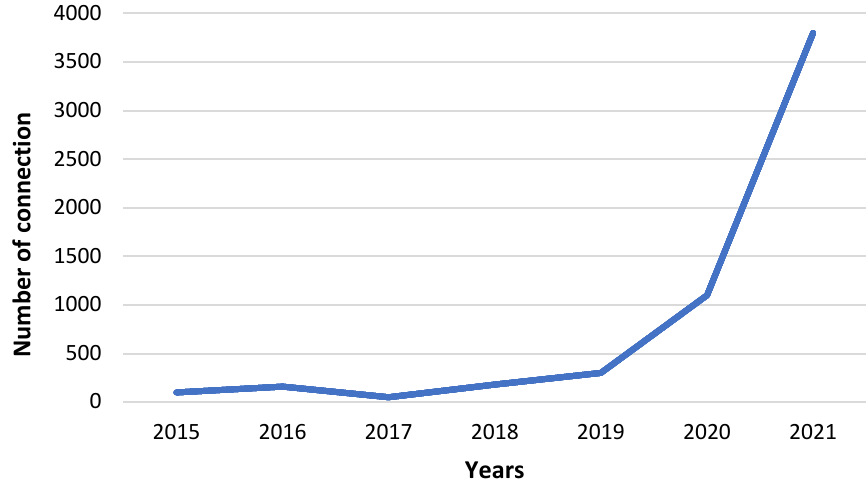
Figure 4. Number of rejected connection applications in 2015–2021.